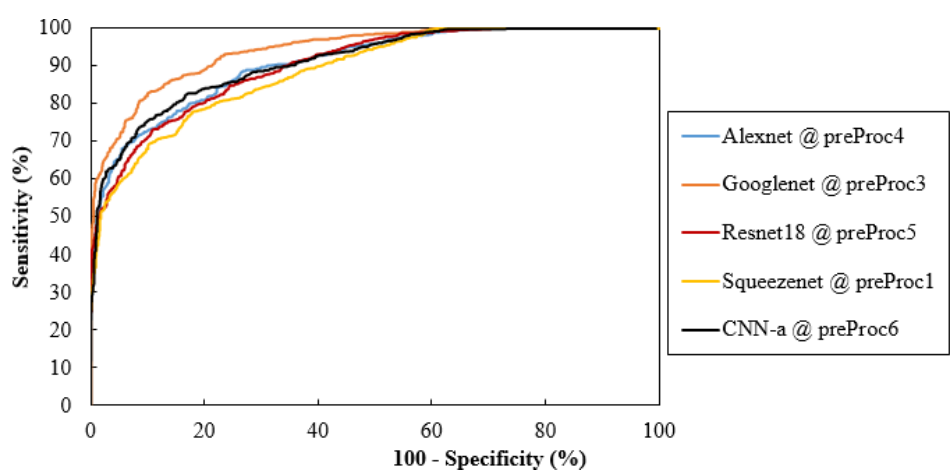
Figure 6. Comparisons of ROC curves for the CNNs and training data with the best AUC values;